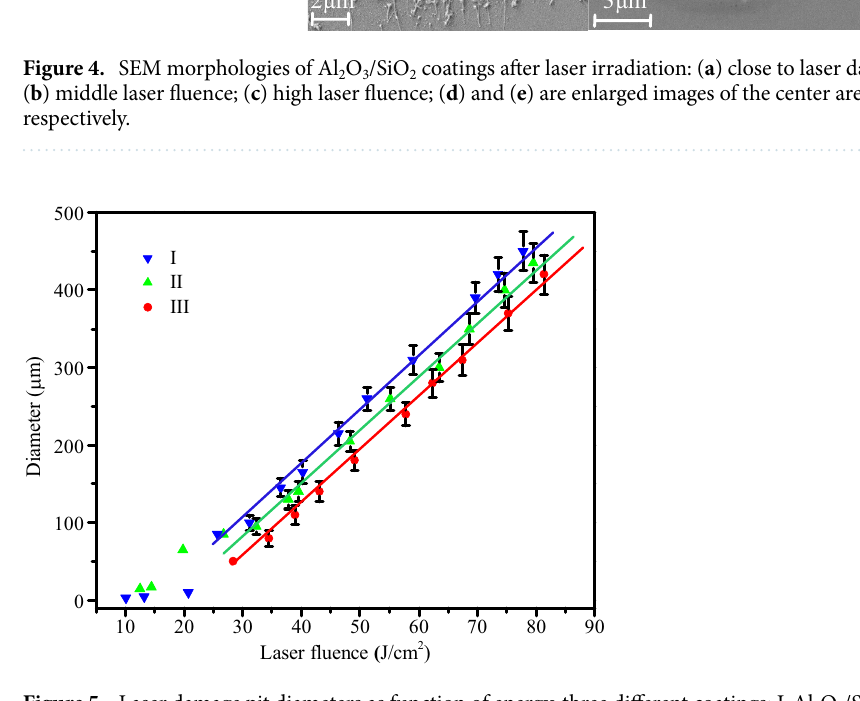
Figure 5. Laser damage pit diameters as function of energy, three different coatings: I-Al 2 O 3 /SiO 2 , II-Ta 2 O 5 /